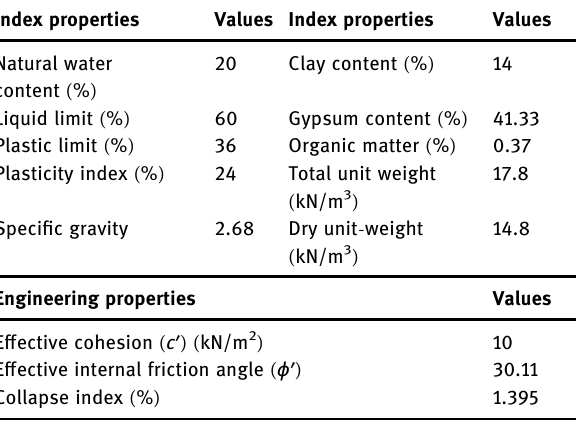
Table 1: Index and strength properties of Al - Jazirah soil [ 14